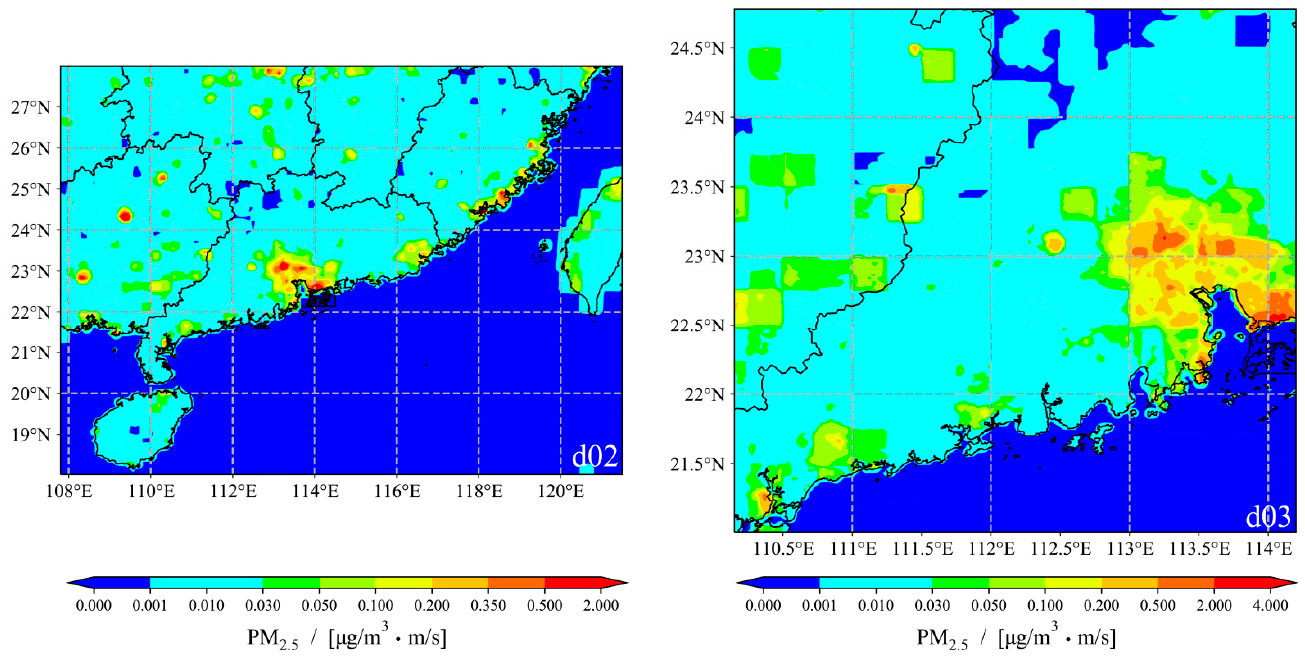
Figure 3. Spatial distributions of PM 2.5 emission rates of the inner domains.